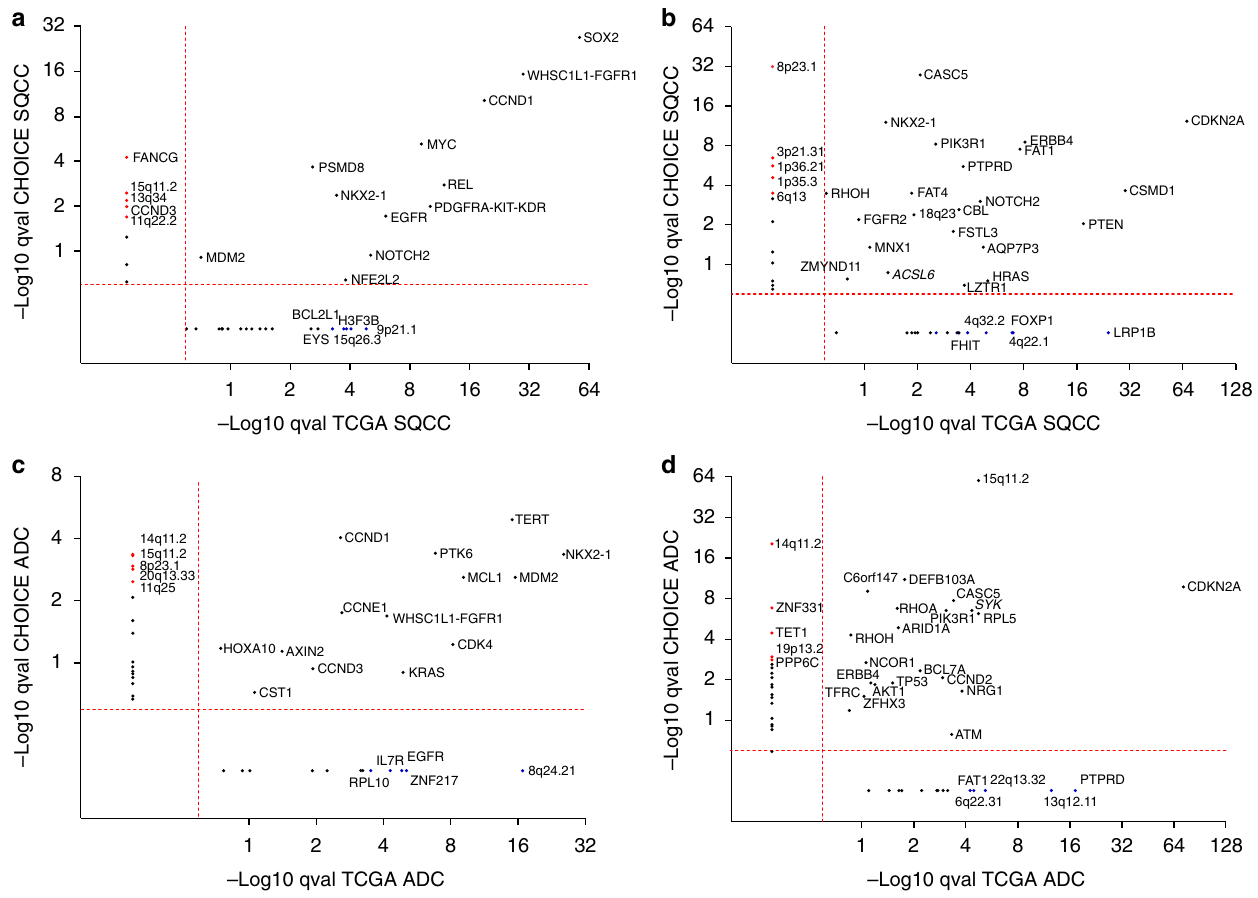
Fig. 1 Copy number variations in the CHOICE versus TCGA NSCLC data. a SQCC focal ampli fi cations. b SQCC focal deletions. c ADC focal ampli fi cations. d ADC focal deletions. The GISTIC 2.0 algorithm was used to identify signi fi cantly recurrent copy number gains and losses in ADC and SQCC population, respectively. The q values for ampli fi cation ( a , c ) and deletions ( b , d ) in the CHOICE study were plotted against the q values from the TCGA datasets. CNVs with q values <0.25 were signi fi cant. Representative genes in focal regions were used whenever possible. Red dots: signi fi cant focal events only in the CHOICE cohort (ADC); blue dots: signi fi cant focal events only in TCGA dataset (SQCC). Red dashed line: q value cutoffs. Source data are provided as